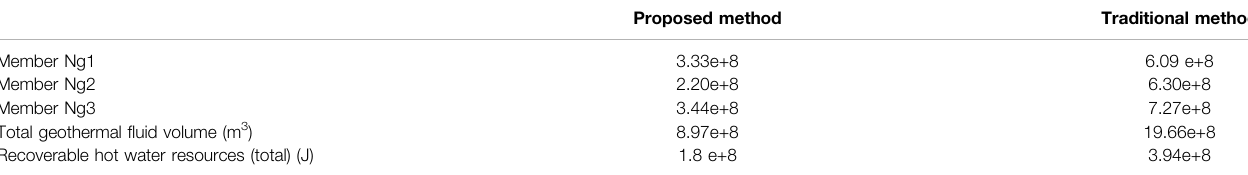
TABLE 4 | The geothermal fl uid volume calculation (Ng1 – Ng3), compared with the traditional volumetric method